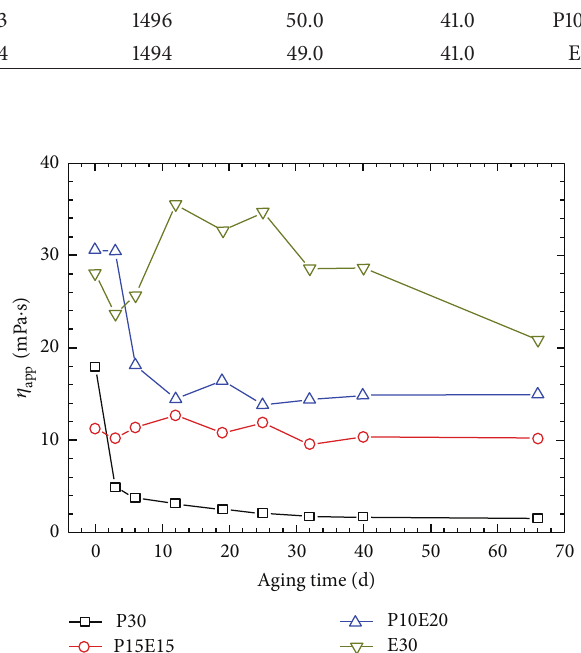
Figure 3: Long-term thermal stability of HPAM/EDAB hybrid samples in comparison with EDAB and HPAM (TDS = 32,868 mg/L, [Ca 2+ ] + [Mg 2+ ] = 873 mg/L, ̇𝛾 = 7.34 s −1 ). Both the aging and measuring temperature is 85 ∘